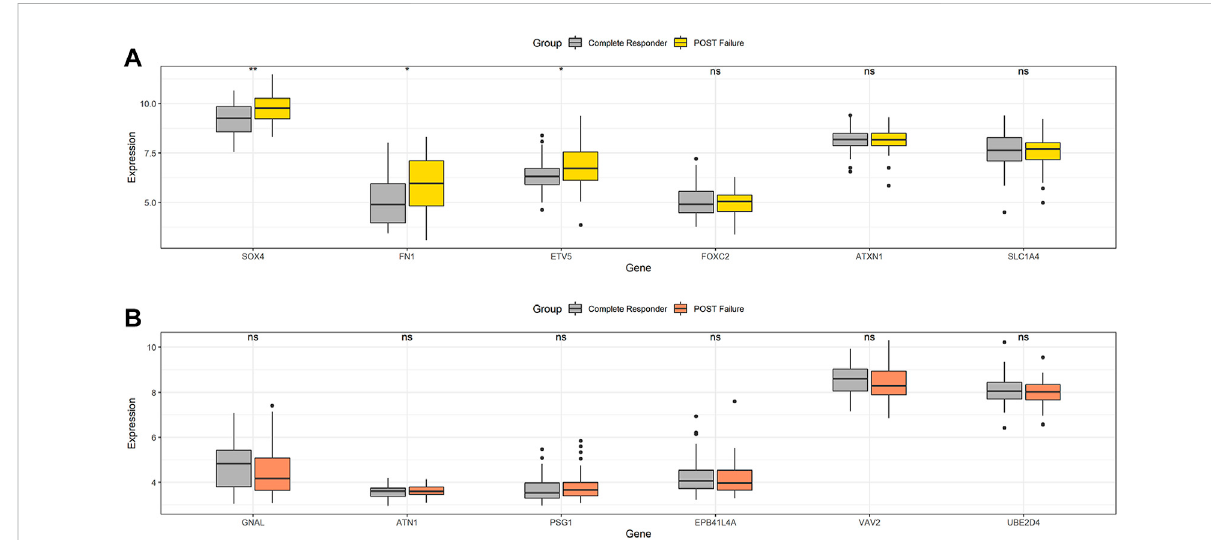
FIGURE 4 In GSE67614, tumor tissues with post-operative radiation therapy failure had higher expression of upregulated radioresistant genes FN1, SOX4 and ETV5 (A) , while none of the downregulated radioresistant genes were downregulated simultaneously (B) . * p < 0.05, ** p < 0.01.